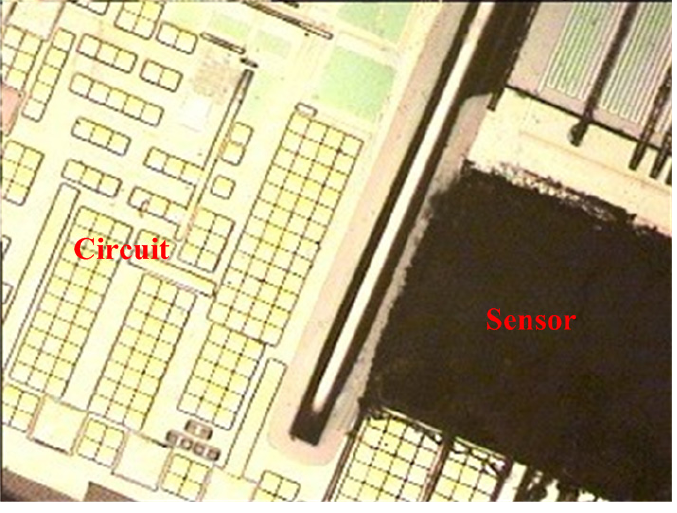
Figure 6. Image of the ammonia sensor after the